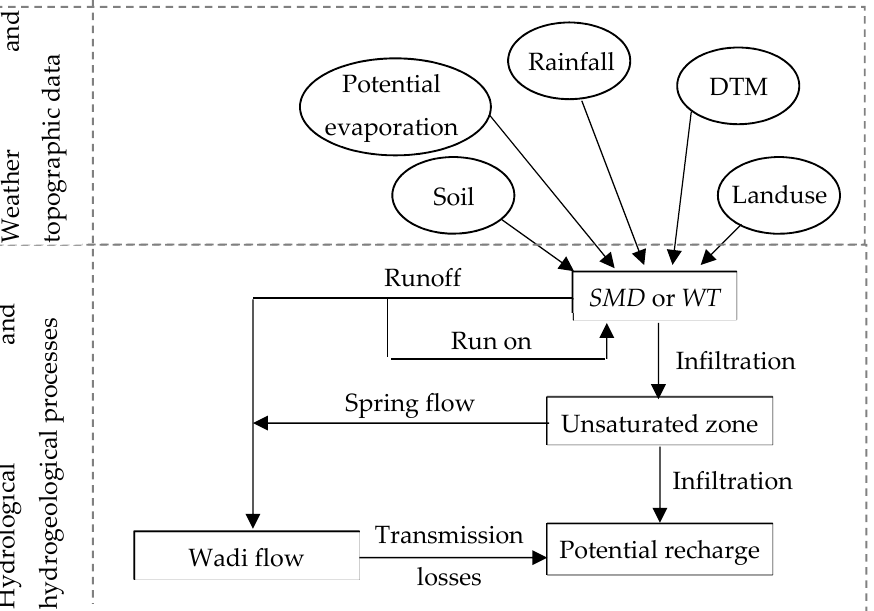
Figure 4. Framework of the recharge model ZOODRM with hydrological processes applied in this study.